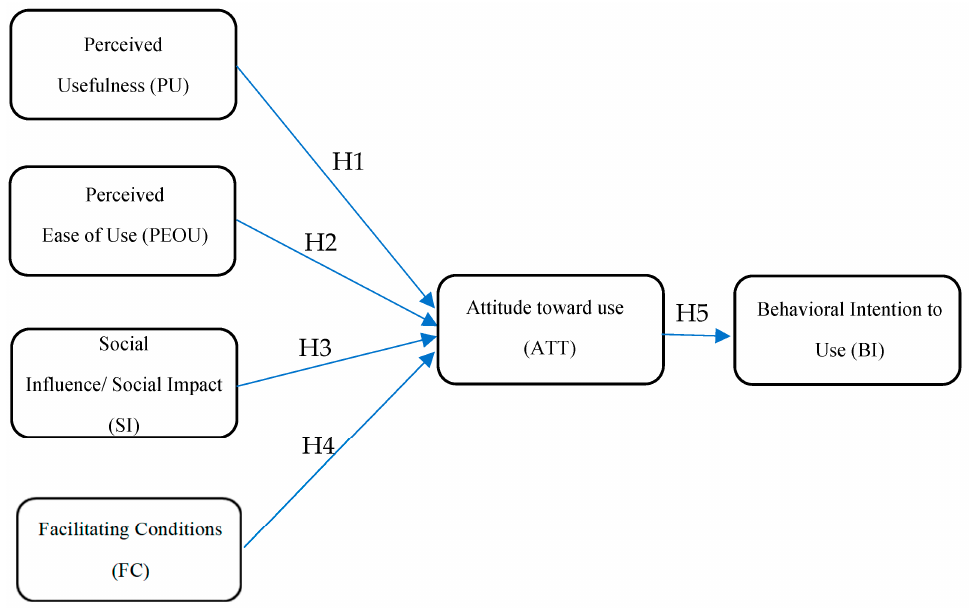
Figure 1. Research Model.